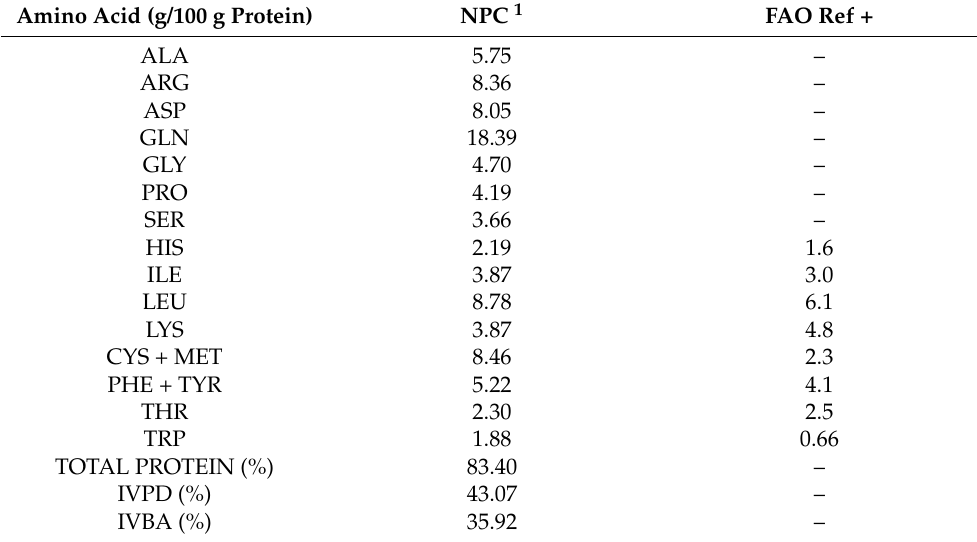
Table 1. Amino acid composition of novel protein concentrate (NPC) of rice ( Oryza sativa ).